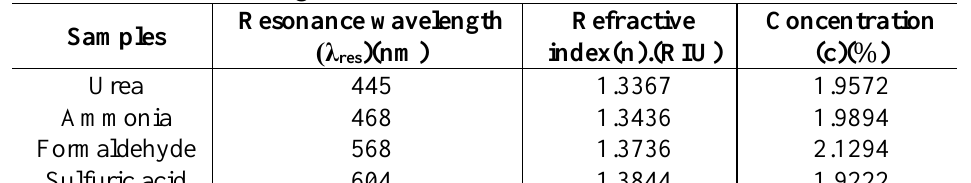
Table 2: Resonance wavelengths of different values of concentration and refractive index.